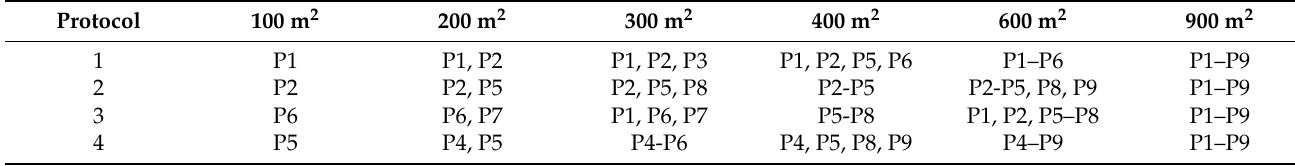
Figure 2. Layout of the sampling plot of 900 m 2 and protocol 1 for combining quadrats into plots of different sizes. Table 2. Four protocols for combining quadrats into plots of different